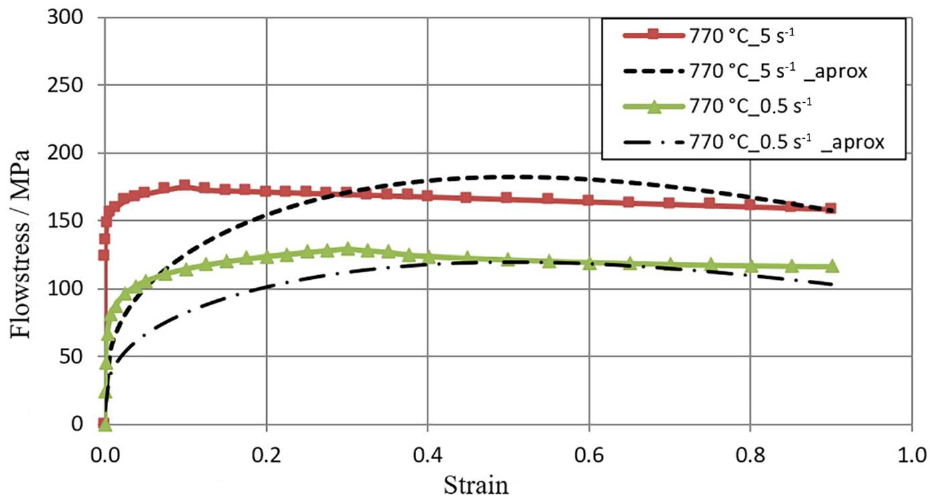
Figure 5. σ p − ε M5 alloy flow curves obtained for the temperature T = 770 ◦ C in the range of ´ ε Figure 5. σ p −ε M5 alloy flow curves obtained for the temperature T = 770 °С in the range of έ strain strain rate from 0.5 to 5.0 s − 1 using the Gleeble metallurgical process simulator 3800; (1) continuous rate from 0.5 to 5.0 s −1 using the Gleeble metallurgical process simulator 3800; (1) continuous lines — lines—experimental data; (2) dashed lines—data after experimental data; (2) dashed lines — data after approximation.